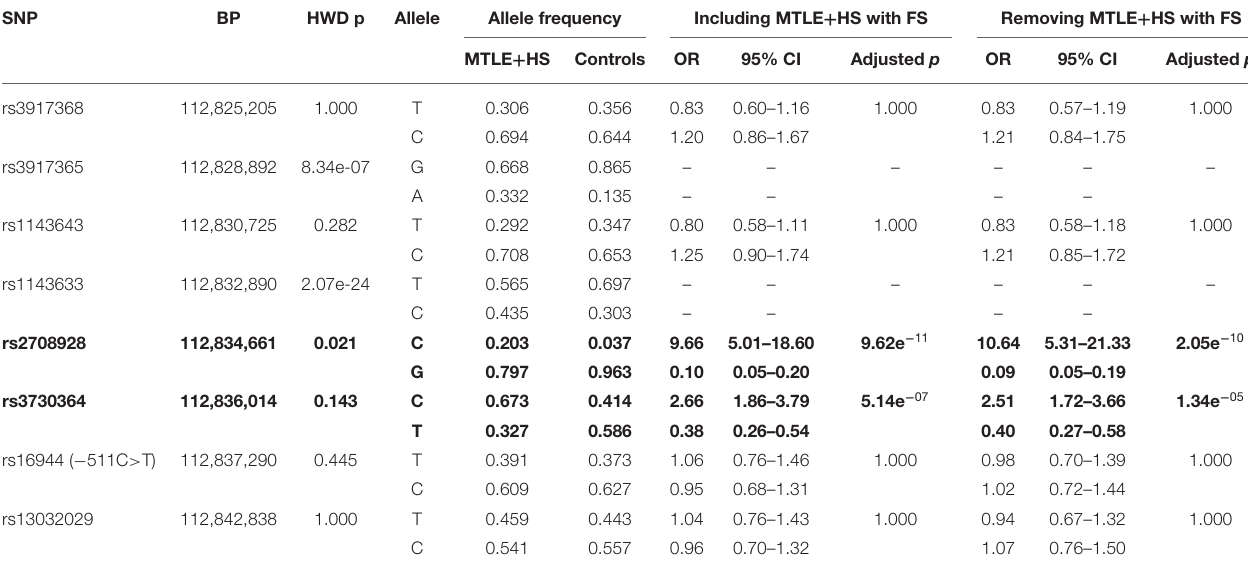
TABLE 3 | Results of the logistic regression for the eight SNPs analyzed within the IL1B gene. SNP BP HWD p Allele Allele frequency Including MTLE + HS with